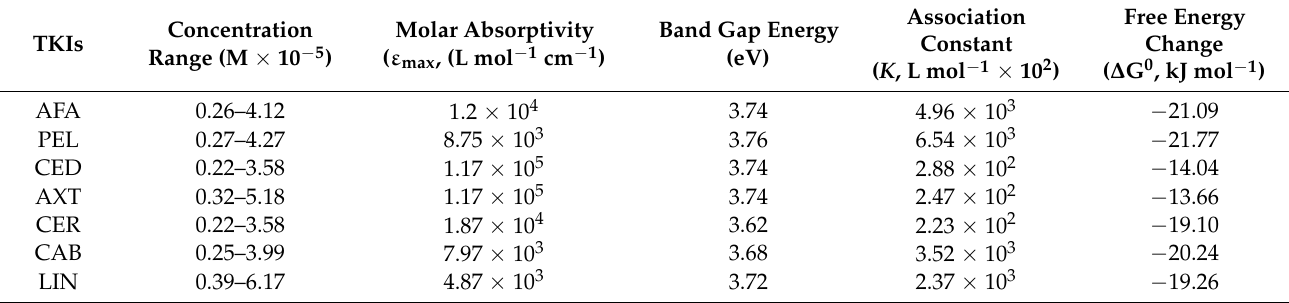
Figure 3. Tauc plot of energy (h υ , in eV) against ( α h υ ) 2 against for CT complex of iodine with CER and LIN. Table 3. Spectrophotometric parameters of the CT reaction of iodine with TKIs.